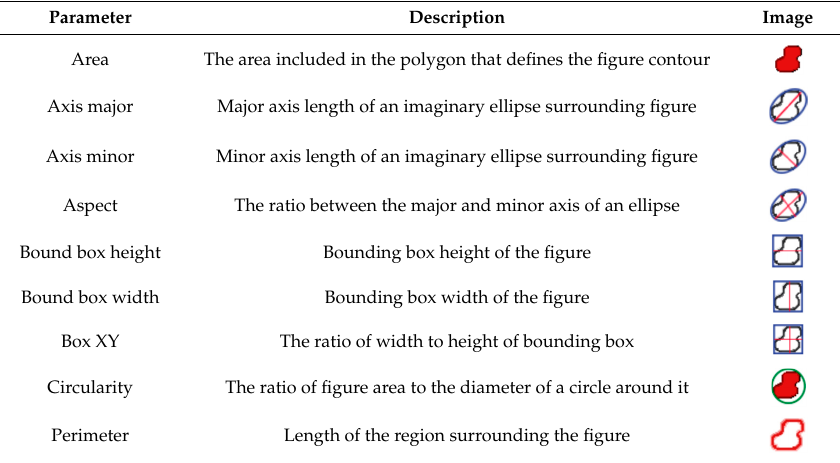
Table 1. Geometric parameters of Image-Pro software.